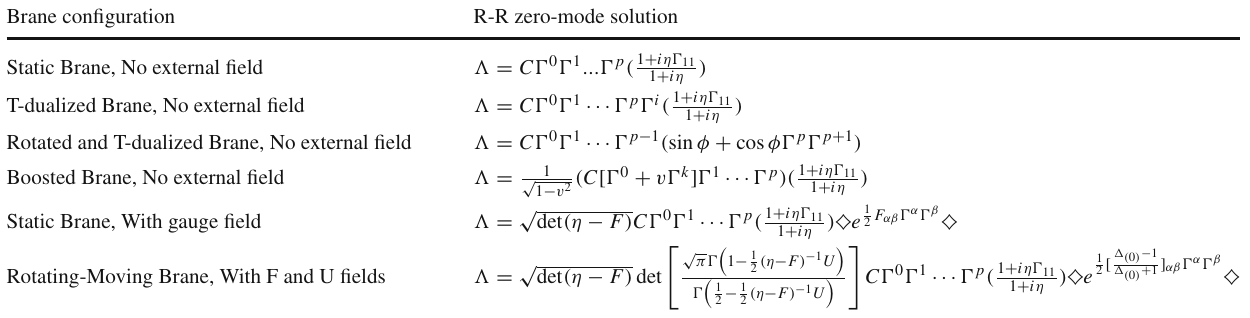
Table 1 some branes configurations and their corresponding zero-mode R-R sector solutions Brane configuration R-R zero-mode